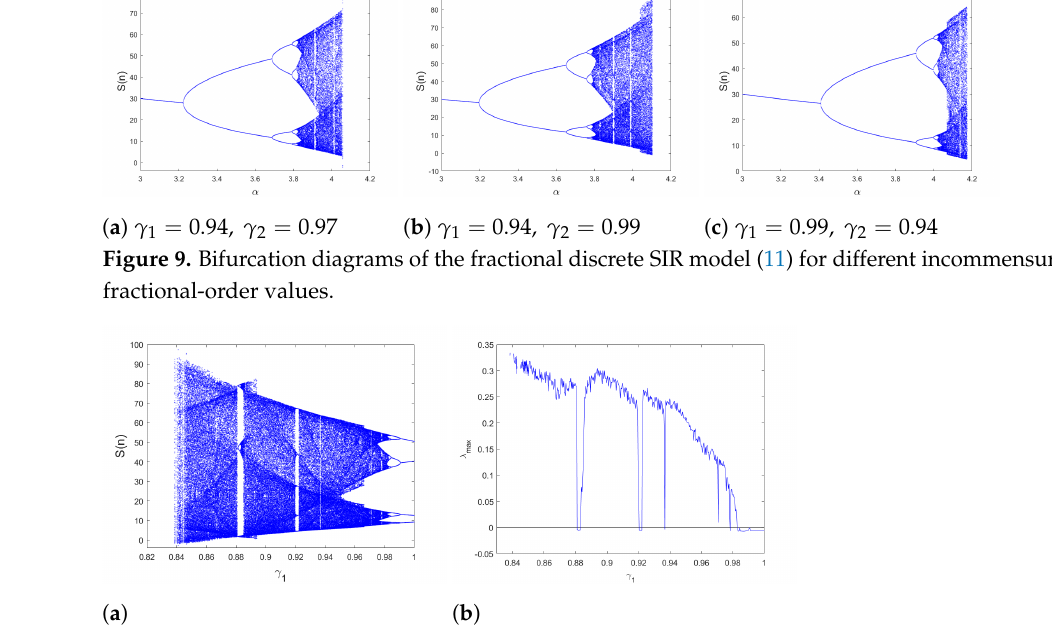
Figure 10. ( a ) Bifurcation diagram versus γ 1 of the fractional discrete SIR model (11) for α = 4 and γ 2 = 0.94. ( b ) The maximum Lyapunov exponents.